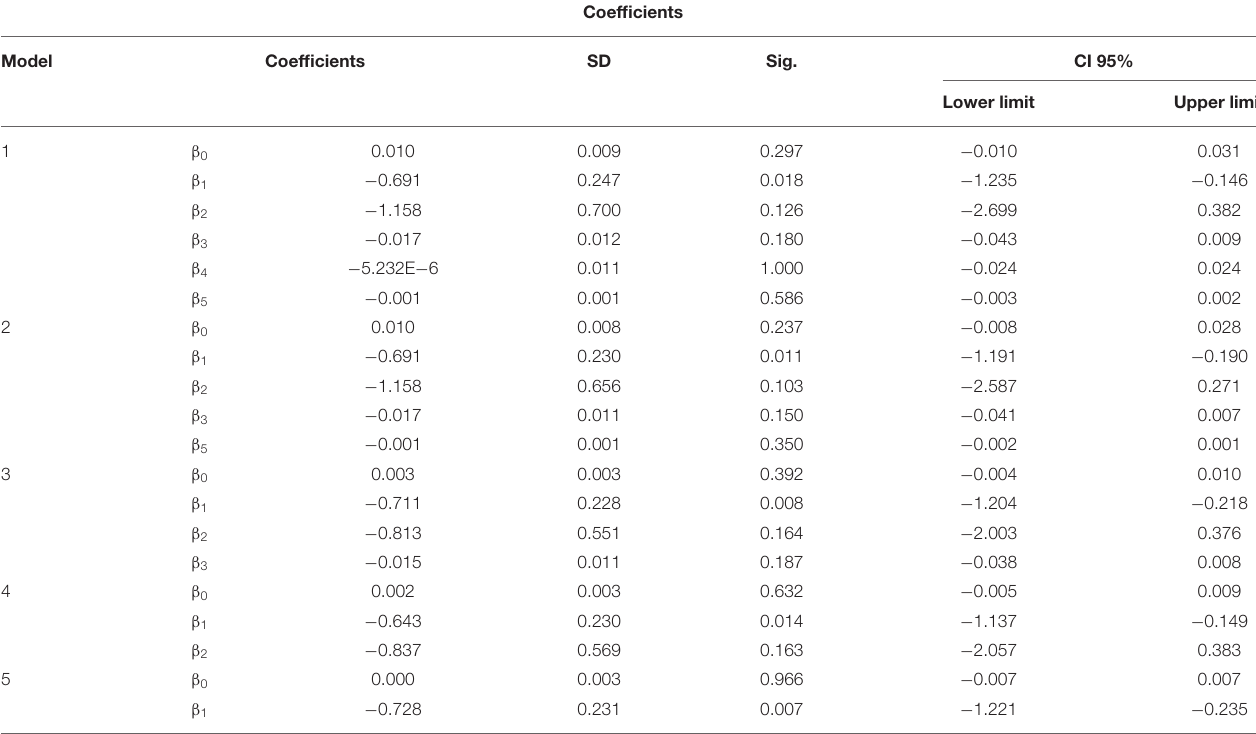
TABLE 2 | Results of the regression analysis for the period